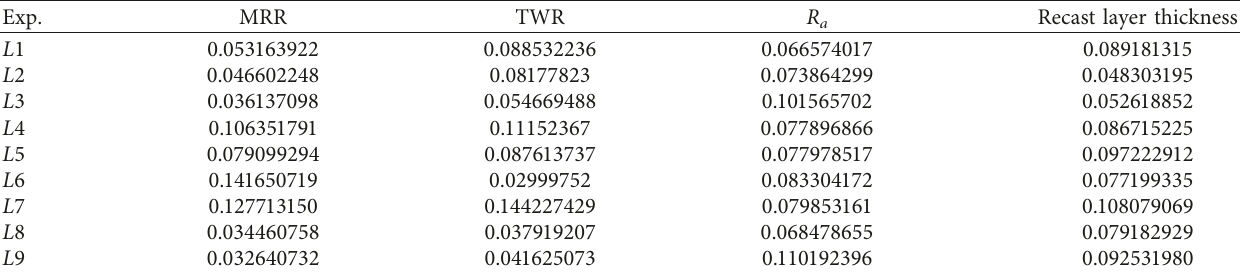
Table 16: Weighted normalized matrix.